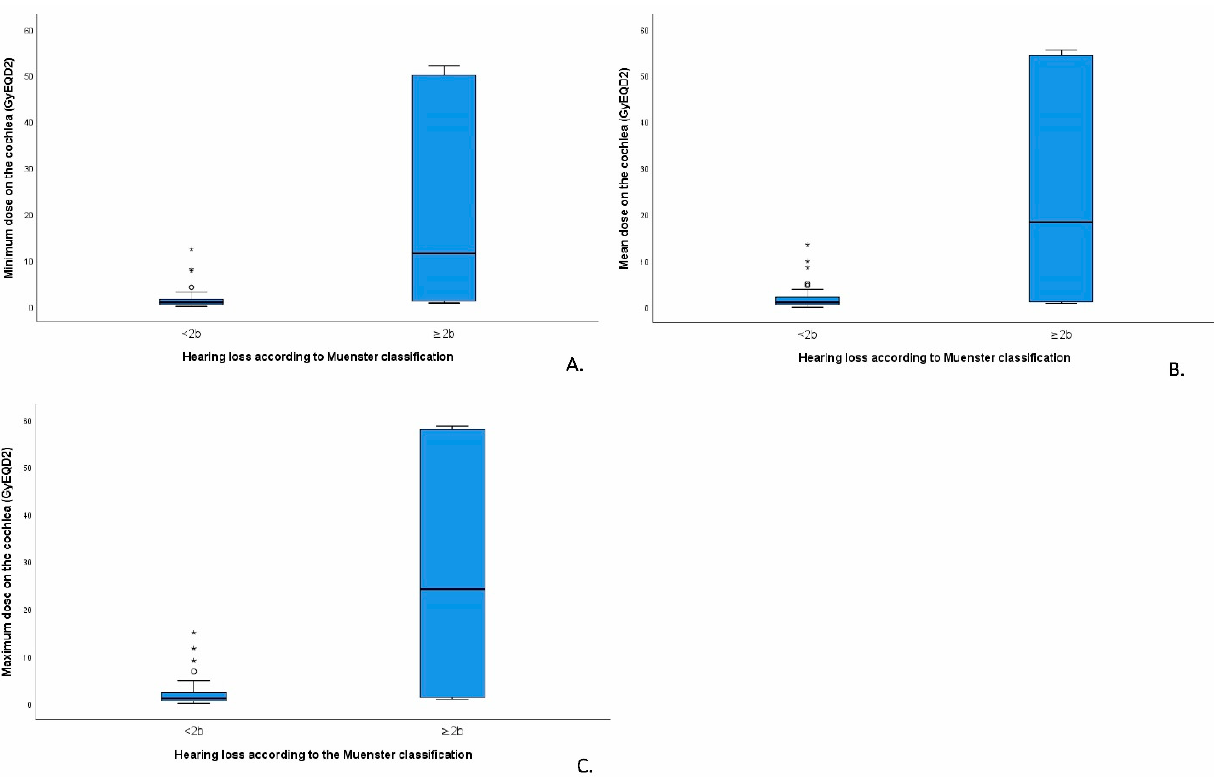
Figure 2. Boxplots showing minimum ( A ), mean ( B ) and maximum ( C ) irradiation dose on the cochlea (GyEQD2) in survivors without (Muenster < 2b) and with deleterious hearing loss (Muenster ≥ 2b). Outliers are indicated with *.